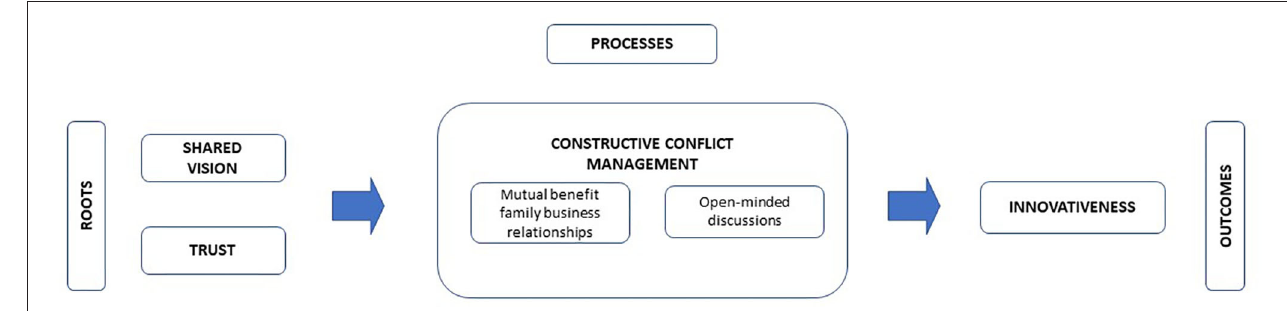
FIGURE 1 | Theoretical model of this research. Source: Adapted from Alvarado-Alvarez et al.